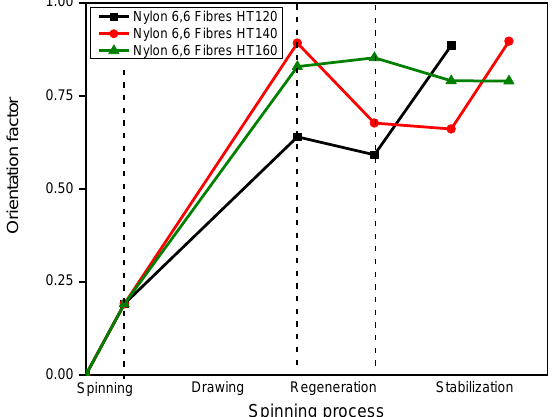
Drawing Regeneration Stabilization Spinning process Scheme 1. Orientation changes in the formation of the nylon 6,6 fibres.